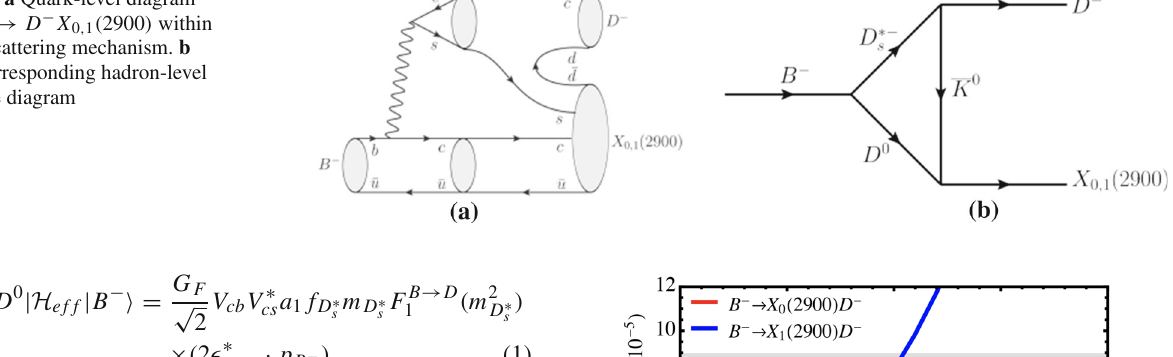
(cid:5) D ∗− D 0 | H ef f | B − (cid:6) = s